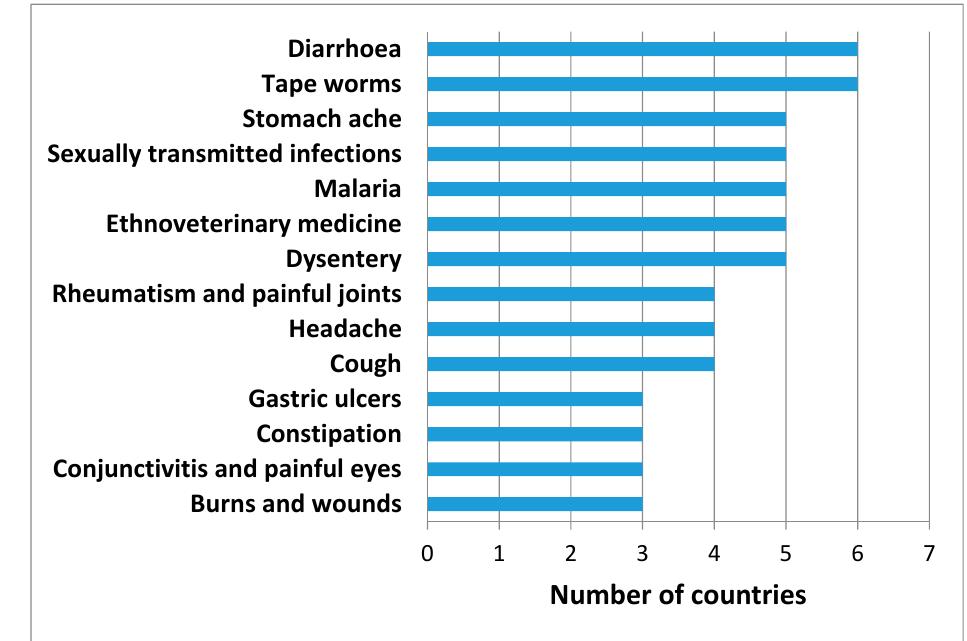
Figure 2. Cross-Cultural agreement among ethnomedicinal uses of B. micrantha in three or more countries in the tropics.